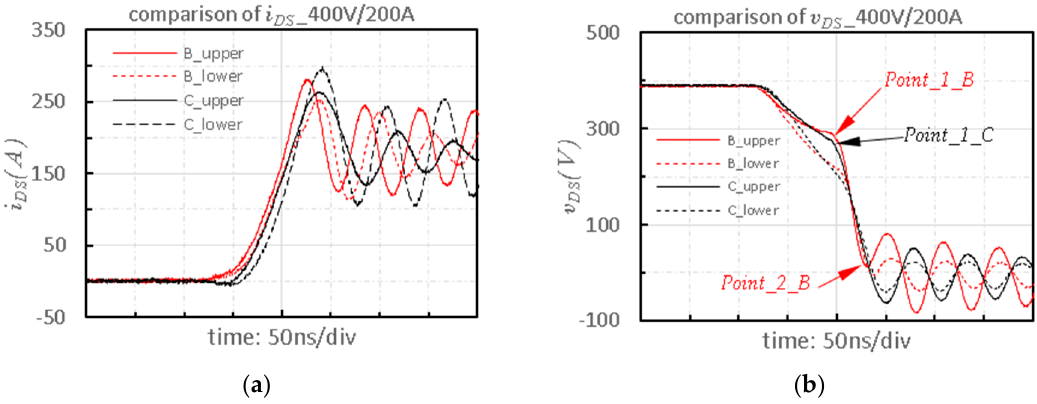
Figure 5. The comparison of turn-on transient waveforms of the modules with the same structure design but different power dies under condition of high V DD : ( a ) waveform of i DS , ( b ) waveform of v DS .